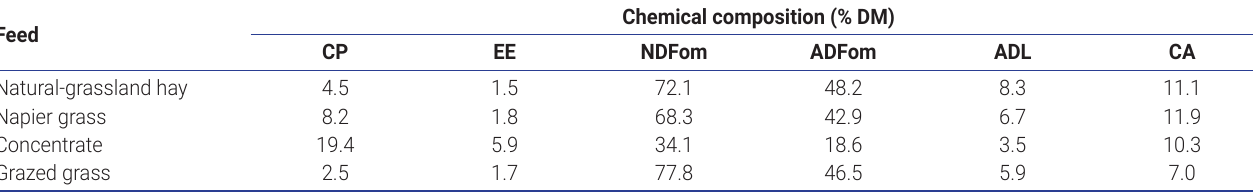
Table 3. Chemical compositions of the feed ingredients used in Exp 2